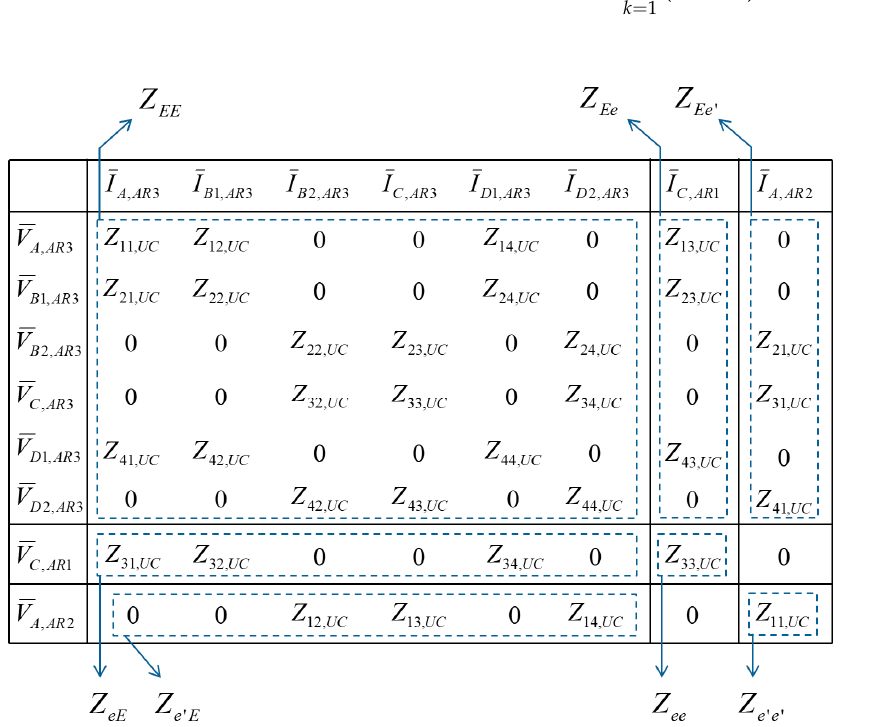
Figure 7. An impedance table defining new Z-parameters for ZRM.